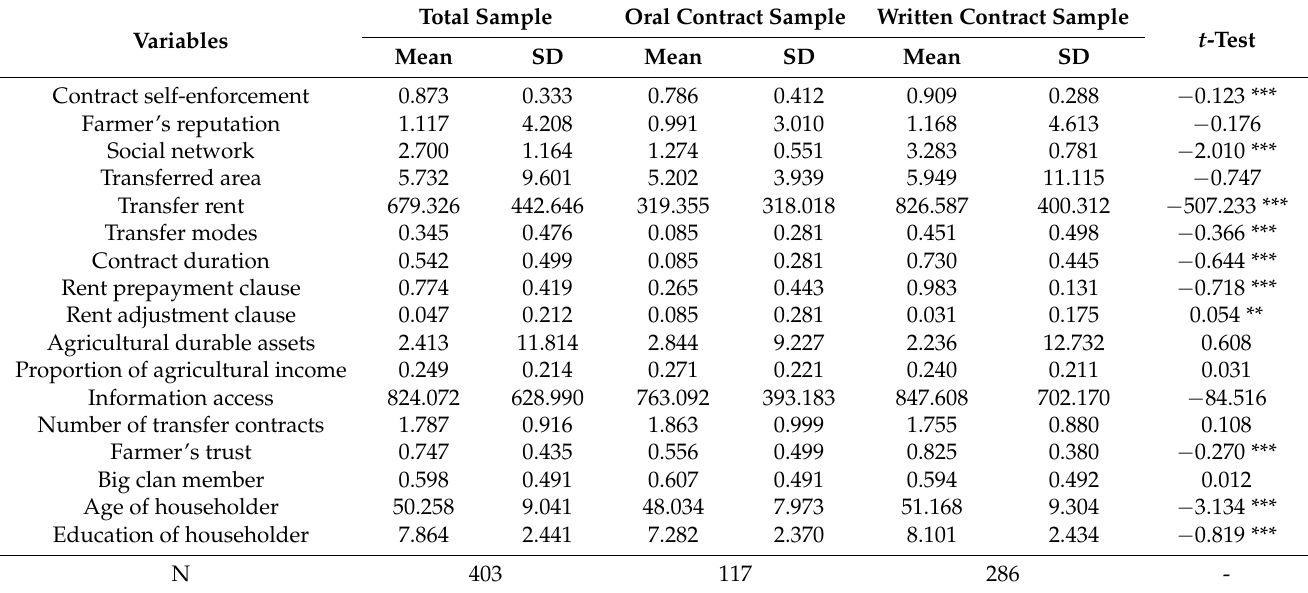
Table 3. Descriptive statistics of contract form selection and performance mechanism